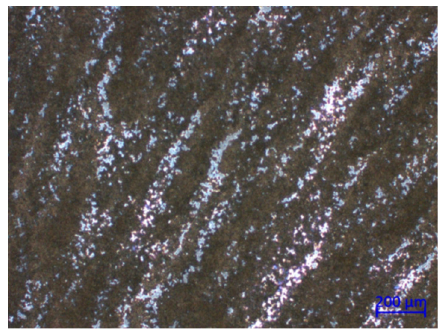
Figure 8. The optical image of the sample prepared by the bismuth nitrate precursor.